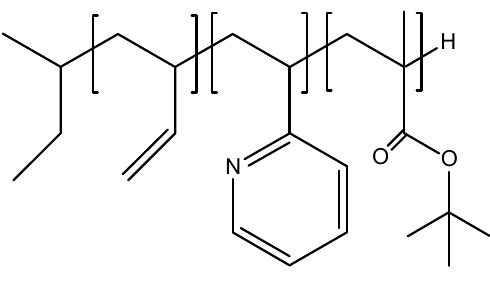
Figure 8. Examples of tri-block copolymers used to form polymeric